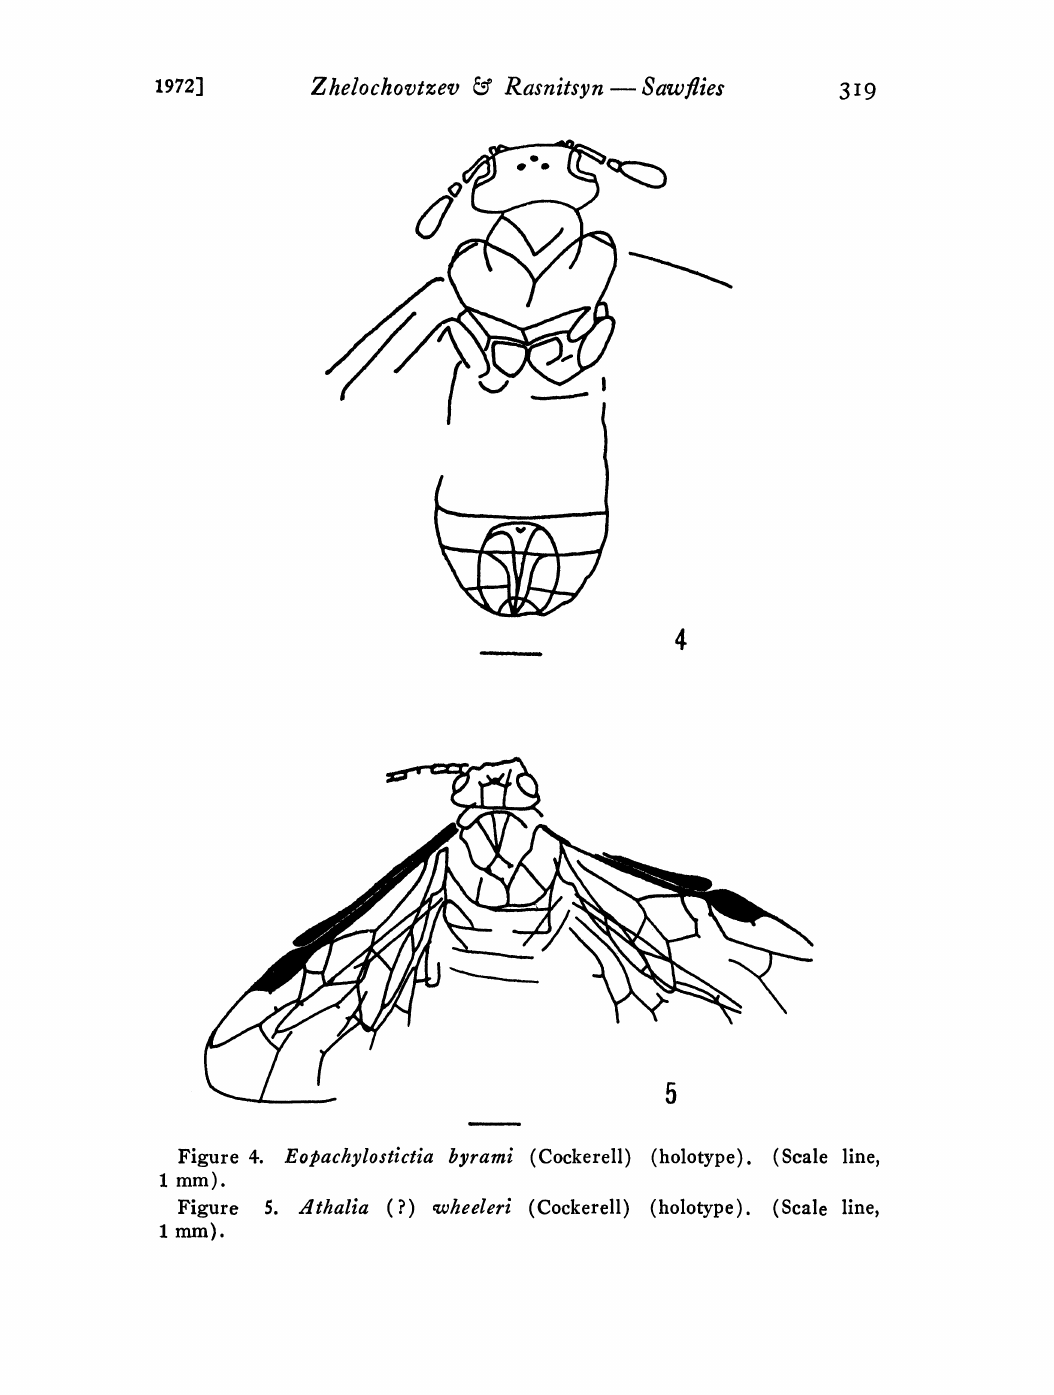
Figure 4. Eopachylostictia byrami (Coekerell) (holotype). (Scale line, 1 mm). Figure 5. .4thalia (?) vheeleri (Coekerell) (holotype). (Scale